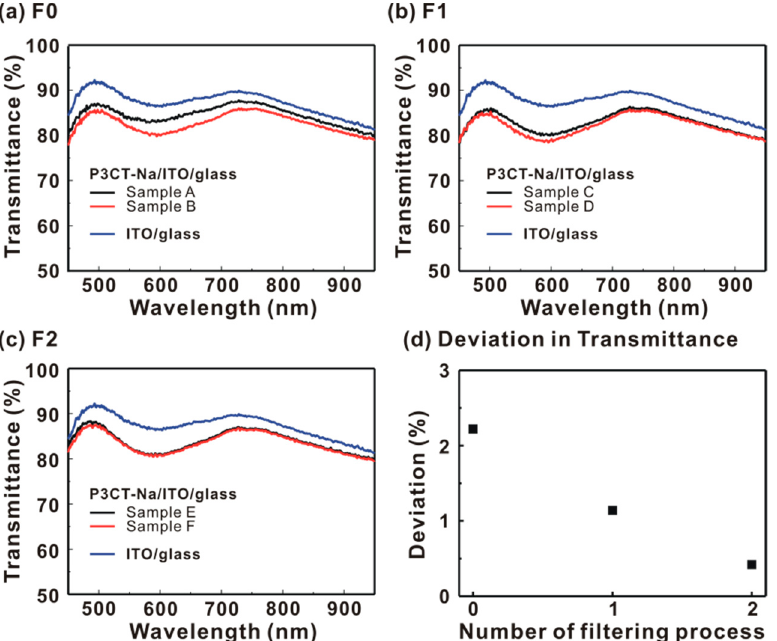
Figure 5. Transmittance spectra of P3CT-Na/ITO/glass substrates. ( a ) Without filter; ( b ) With single-filtering process; ( c ) With double-filtering process. ( d ) Averaged deviation in transmittance spectra from 450 to 650 nm.